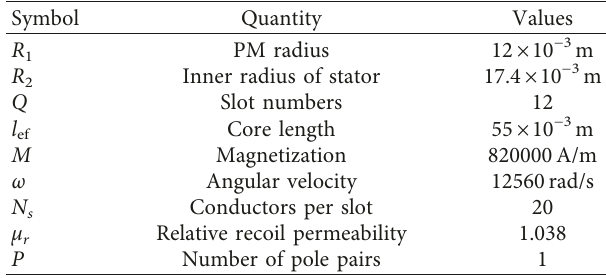
Table 1: Parameters of the high-speed